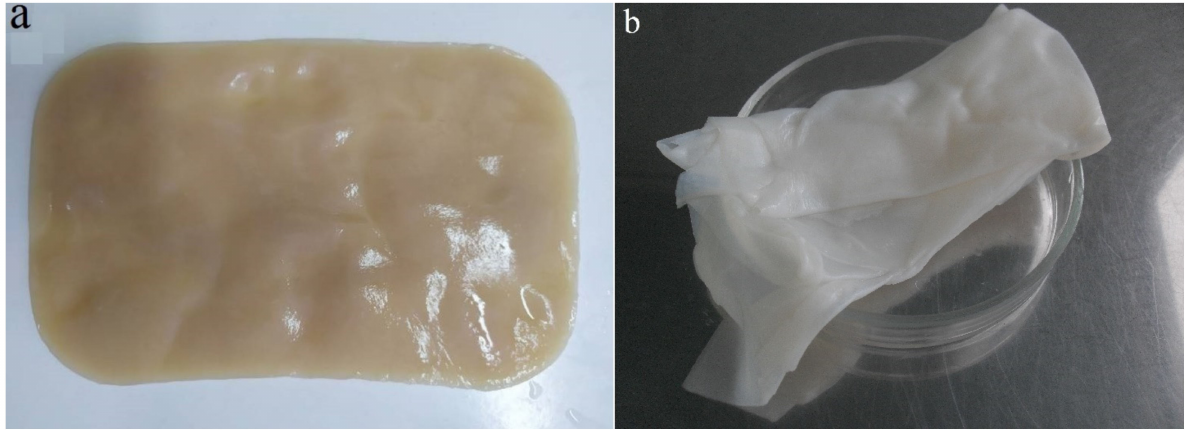
Figure 1. Gel film of BC produced by K. sucrofermentans H-110 using ( a ) molasses medium and ( b ) after